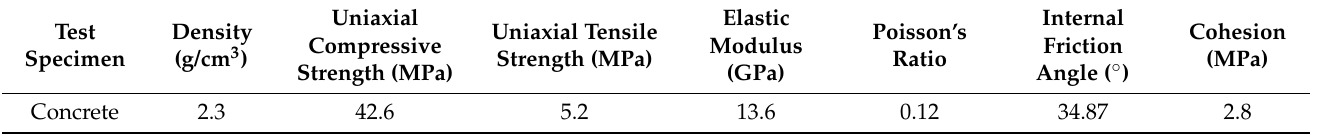
Figure 6. Test device for presplitting and crushing of concrete specimen. Table 2. Mechanical parameters of concrete specimens.